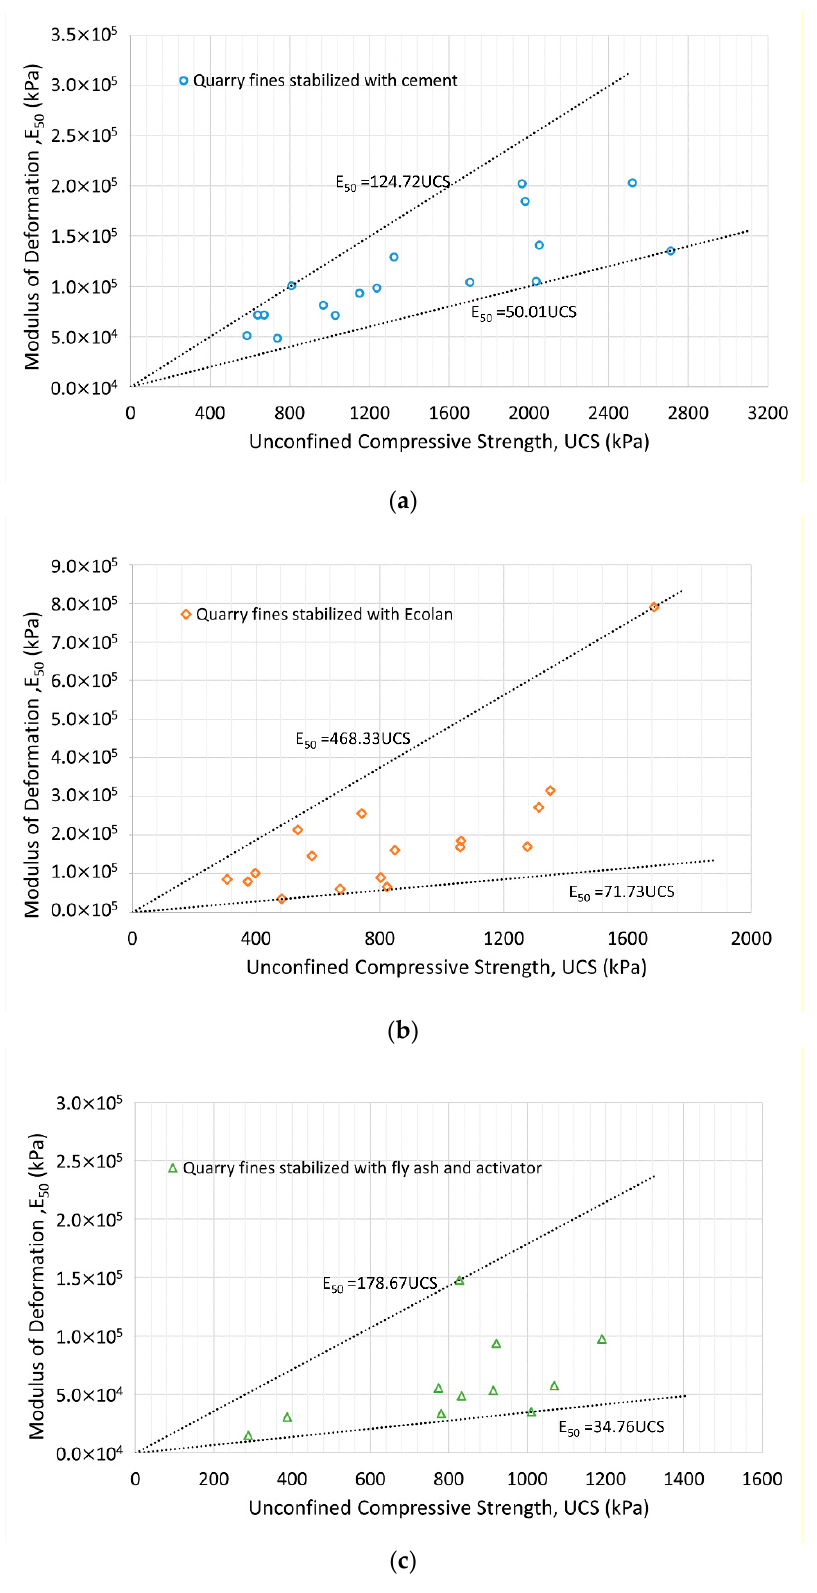
Figure 2. Modulus of deformation versus unconfined compressive strength of stabilized quarry fines: ( a ) Quarry fines stabilized with cement; ( b ) Quarry fines stabilized with Ecolan; ( c ) Quarry fines stabilized with fly ash and activator.